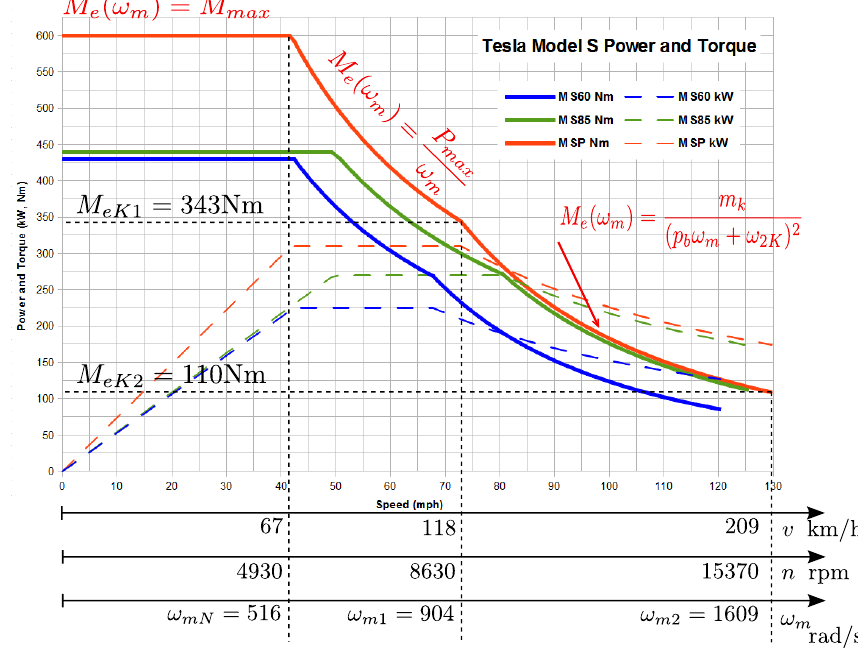
Figure 7. torque–speed and power-speed curves of the